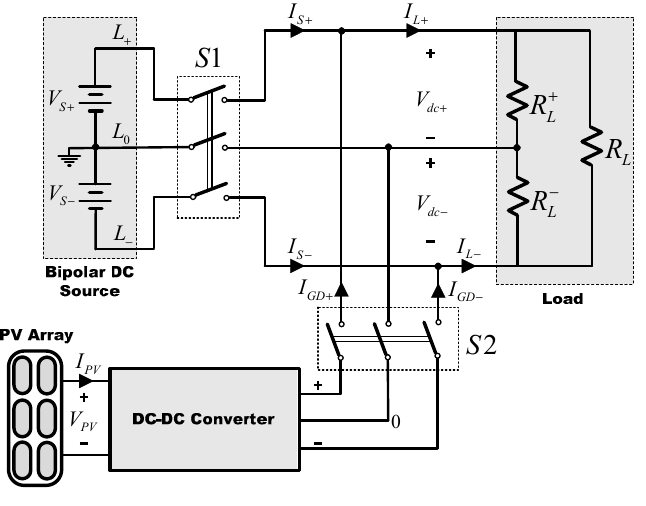
Figure 9. Experimental system.